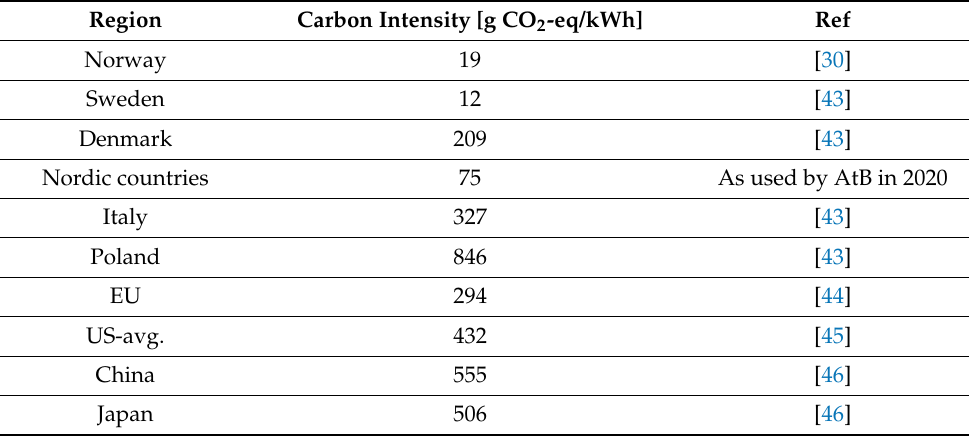
Table 2. Carbon intensity for electricity mix in different